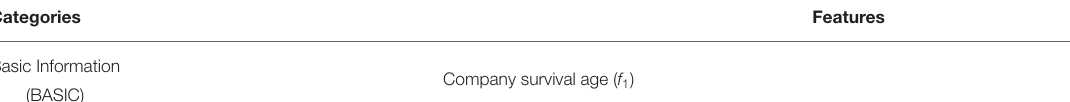
TABLE 2 | Feature indicators of the